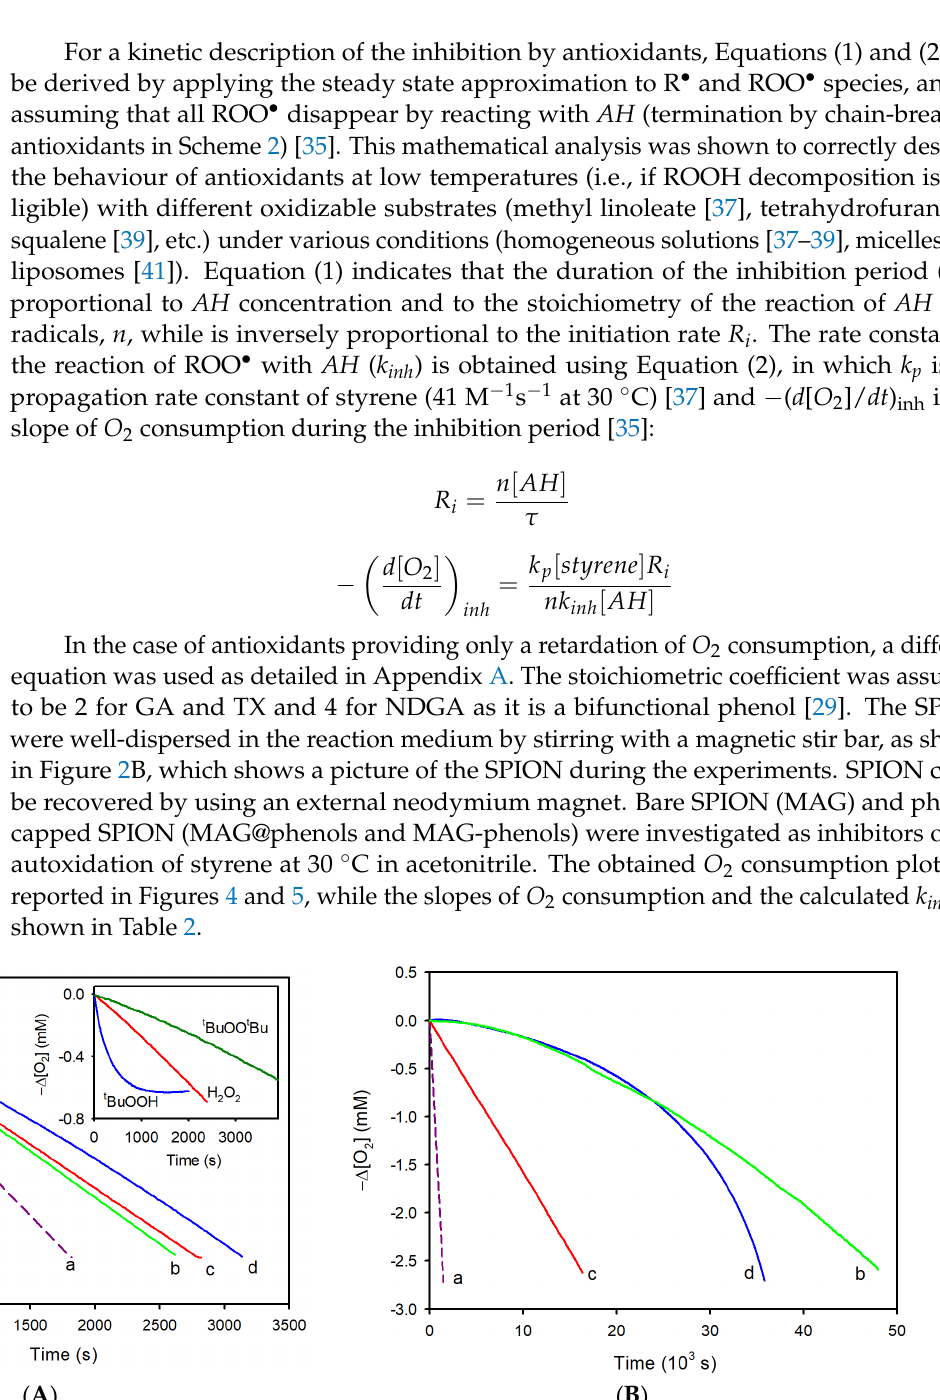
( B ) Figure 5. Oxygen consumption measured during the autoxidation of styrene (4.3 M) in MeCN, initiated by AIBN (25 mM) at 30 °C, in the absence of inhibitors (a, dashed line) or in the presence of the investigated antioxidants: Panel ( A ): MAG@NDGA (b), MAG@GA (c), MAG@TX (d), (all 0.25 mg/mL); Panel ( B ): NDGA (0.54 mM) (b), GA (0.83 mM) (c), TX (0.40 mM) (d), corresponding to the phenol concentration of the experiments reported in Panel ( A ). In the case of phenol-capped SPIONs, a kinetic analysis was performed using the concentration of phenols as obtained by the TGA experiments. By comparing the dashed and the solid lines in Figure 4A, it is evident that bare SPION have a pro-oxidant effect, as they increase the O 2 consumption rate. This aspect was studied in greater detail by performing styrene autoxidation experiments, in which the initiation was not caused by the decomposition of the azoinitiator but was due to the Fenton reaction between MAG and peroxides. In the inset of Figure 4A, the O 2 consumption measured during the styrene autoxidation initiated by SPIONs in the presence of t BuOOH, H 2 O 2 or t BuOO t Bu is reported. The results show that a higher production of radicals is observed for hydroperoxides in the order t BuOOH > H 2 O 2 , followed by the dialkylperoxide t BuOO t Bu.